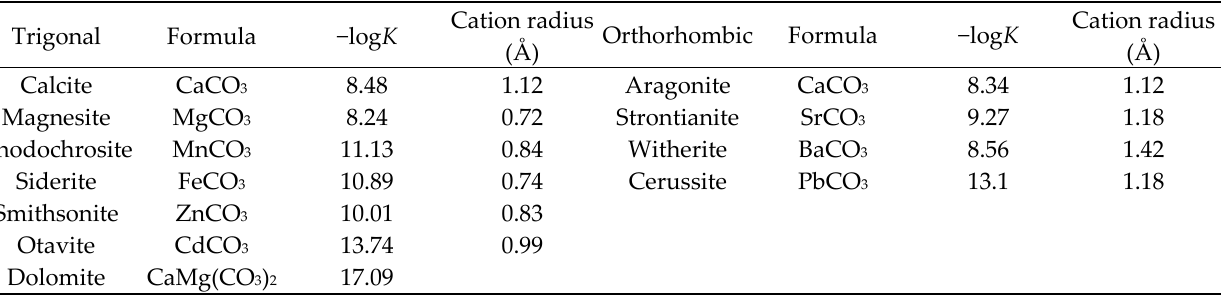
Figure 2. Mineralogy and solubility product (K) of some carbonates at 25 ◦ C [6]. In natural waters, calcium and magnesium are the most common elements and the main reactions involved in the scale precipitation are (1) and